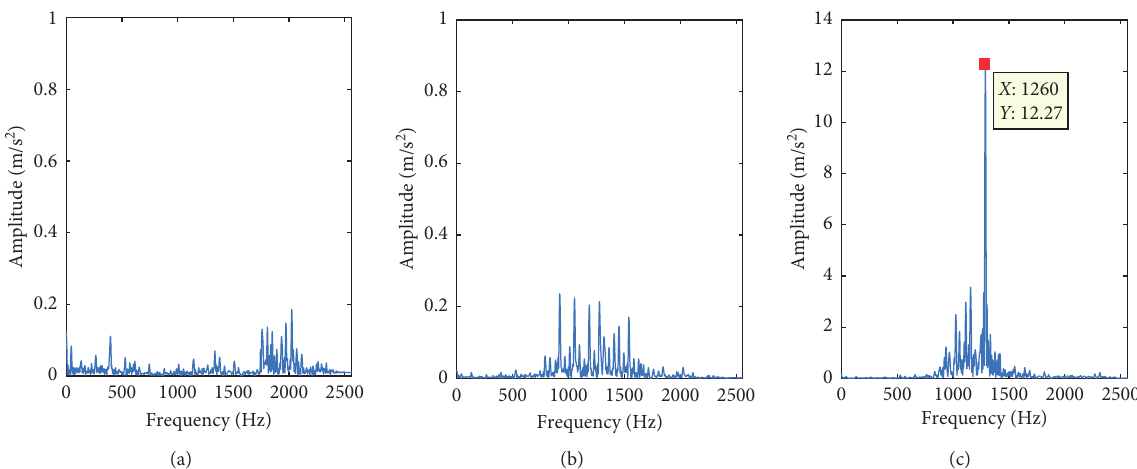
Figure 7: The amplitude spectrum of vibration signals in the three cutting states under cutting conditions: spindle speed 7500r/min, axial depth of cut 0.4mm, radial depth of cut 0.1mm, and feed rate 0.1mm/rev. (a) Stable state. (b) Transition state. (c) Chatter state.